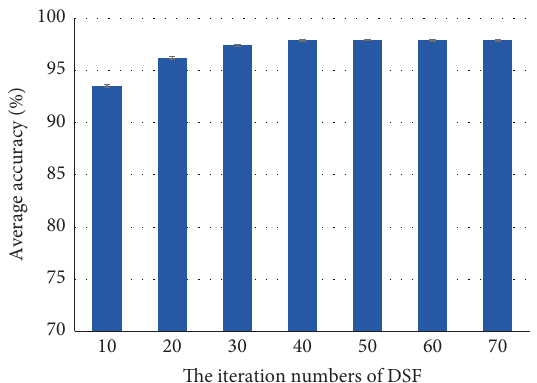
Figure 6: Average accuracy of different iteration number of DSF model.